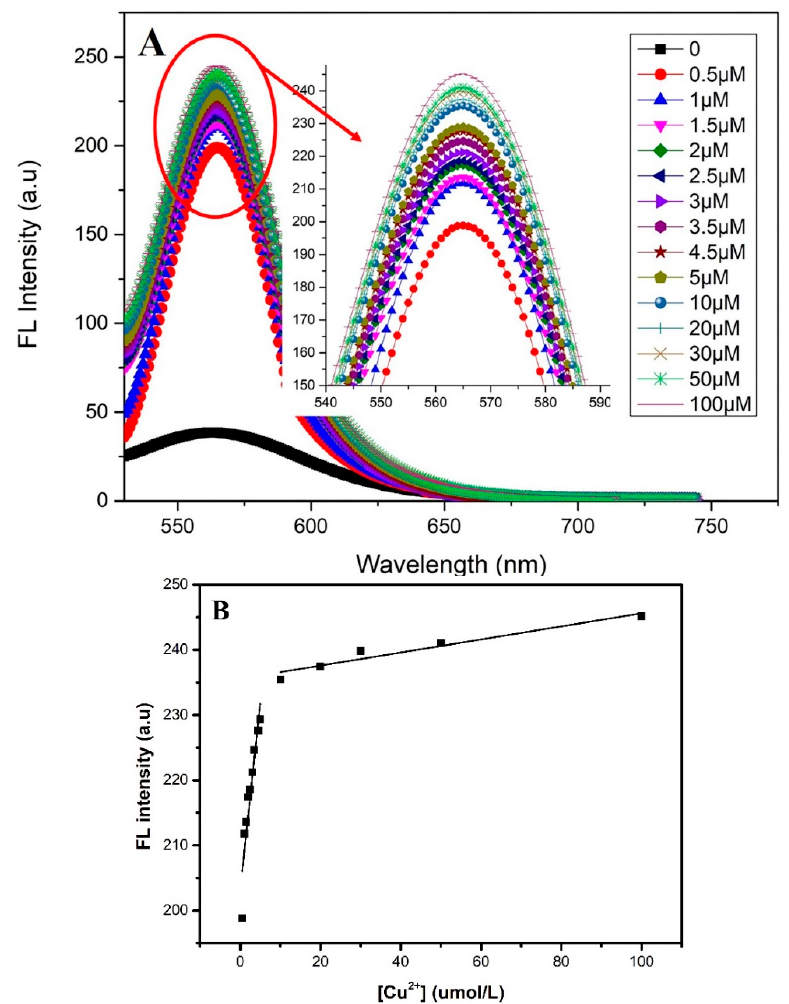
Figure 3. ( A )The fluorescence spectra of the GO-dsDNA-QD ensemble assay upon addition of various concentration of Cu 2+ . Inset: Local fluorescence amplification; ( B ) The relationship between the fluorescence intensity and Cu 2+ concentration.